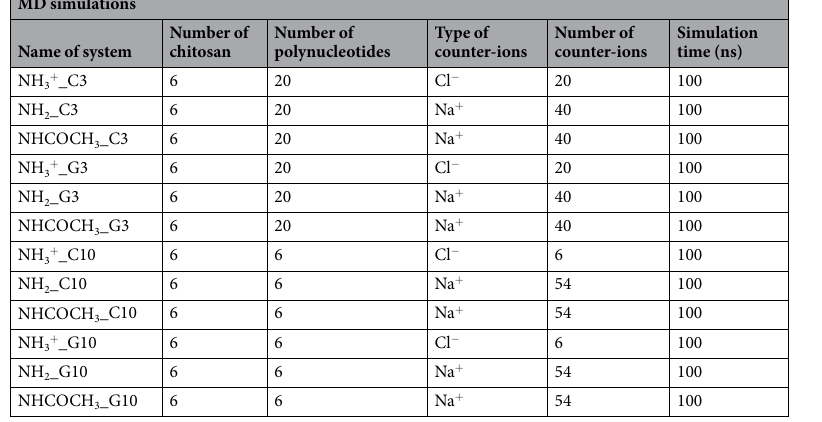
Table 1. All performed simulations in this study.